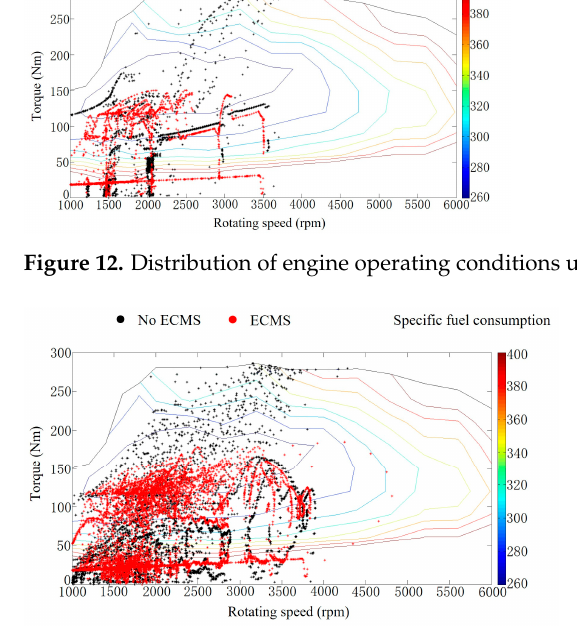
Figure 13. Distribution of engine operating conditions under WLTP test conditions.